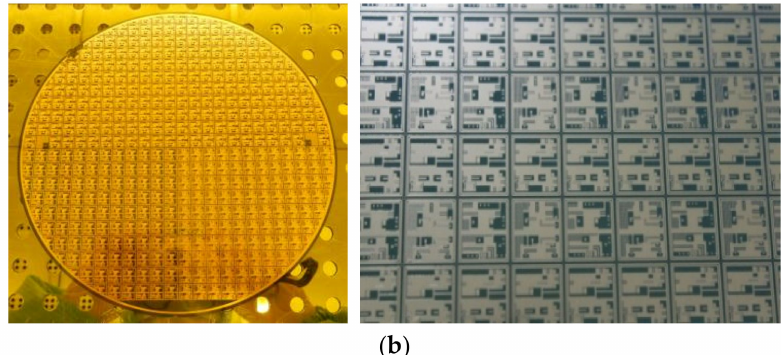
Figure 15. Photos of the 8-inch HR-Si cap and bottom interposer wafers.